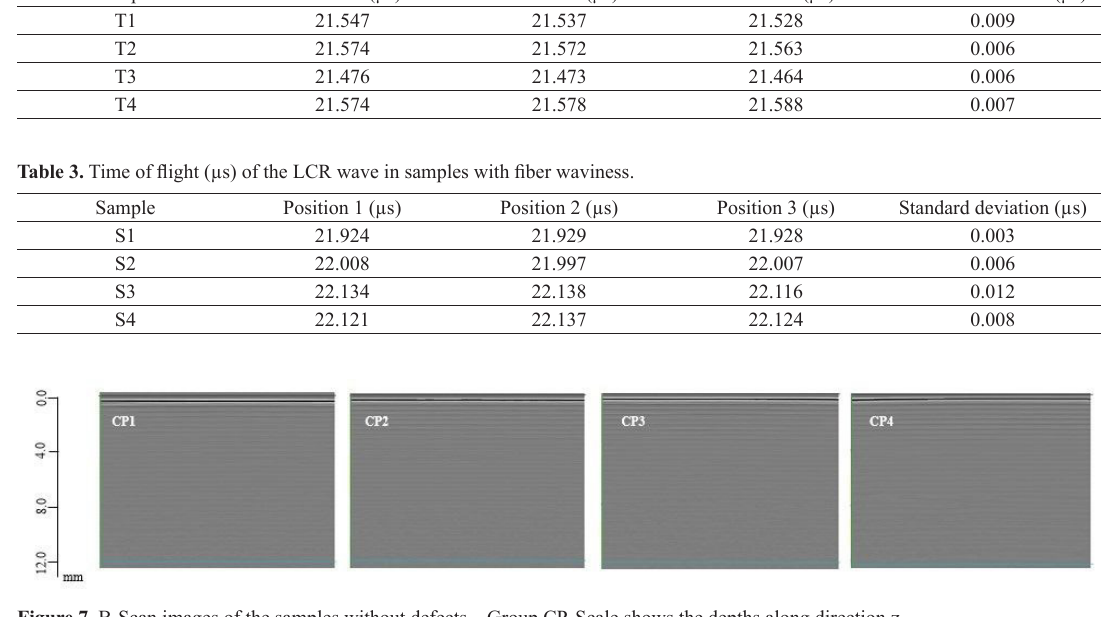
Table 2. Time of flight (µs) of the LCR wave in samples with delamination. Sample